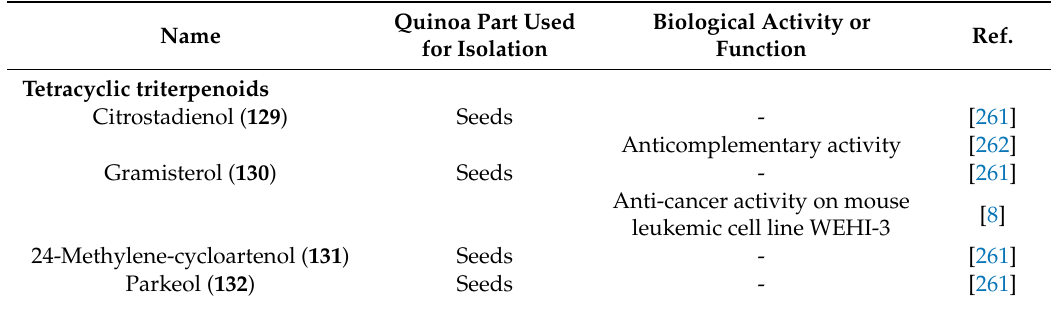
Table 17. Other triterpenoids and their biological activities or